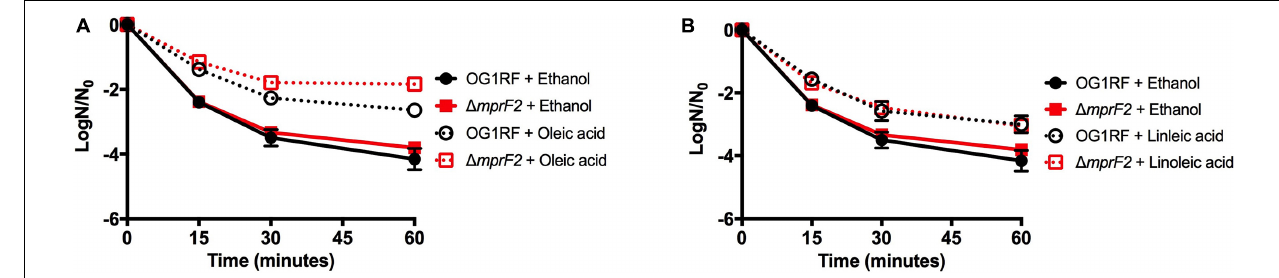
FIGURE 7 | Host fatty acid supplementation protects mprF2 deficient E. faecalis OG1RF from daptomycin challenge. (A) All strains supplemented with oleic acid had statistically increased numbers of survivors vs. the solvent control at all-time points analyzed ( P = 0.002). (B) All strains supplemented with linoleic acid had statistically increased numbers of survivors vs. the solvent control at all-time points analyzed ( P = 0.005). Shown are the averages ± standard deviation for n = 3. OG1RF data is re-plotted from Figures 4A,B .